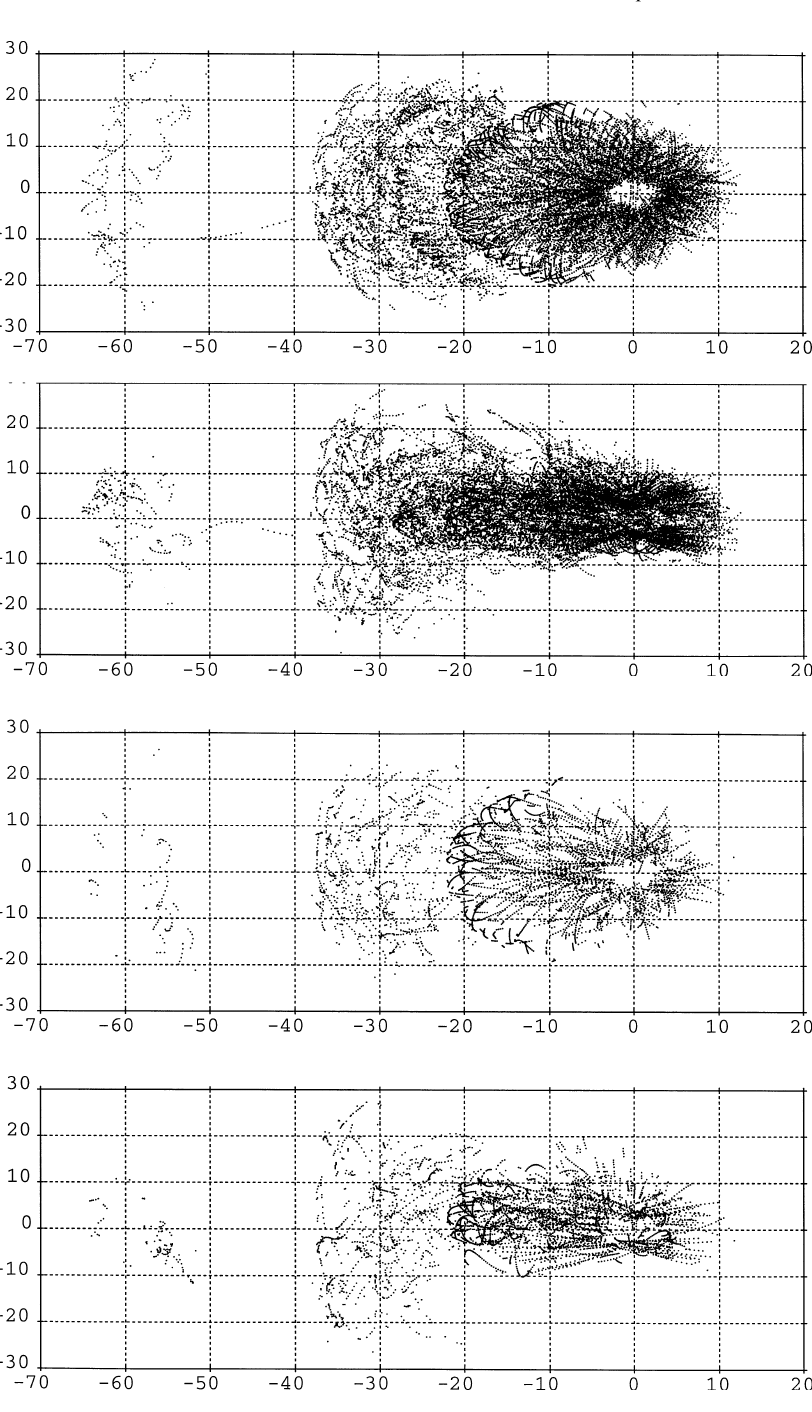
Fig. 3. Similar to Fig. 2 but for a high geomagnetic activity level (Kp = 5). A lack of measurements is observed over the polar regions where field line escape usually occur